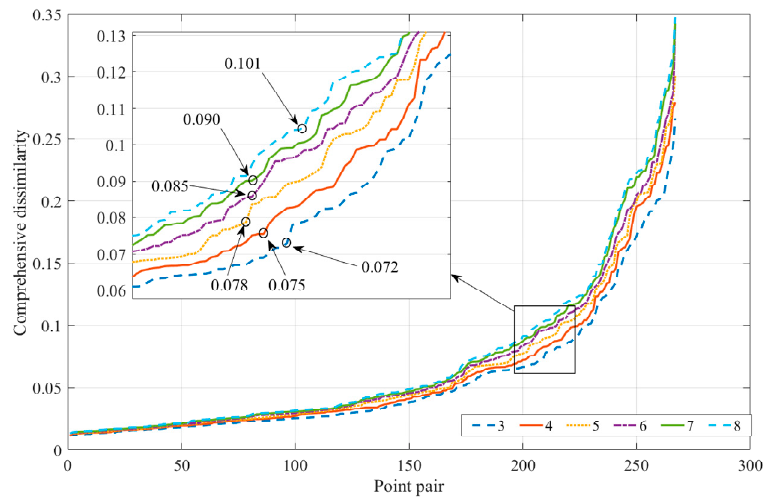
Figure 13. The k Distance curve of integrated distance. Table 2. Clustering evaluation result with different 𝑀𝑖𝑛𝐿𝑛𝑠 and 𝜀 .